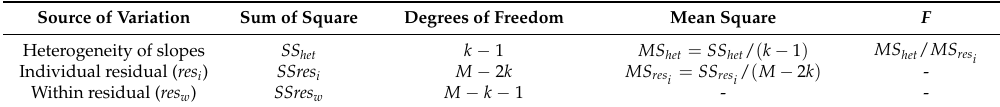
Table 2. Computation table for the heterogeneity of the